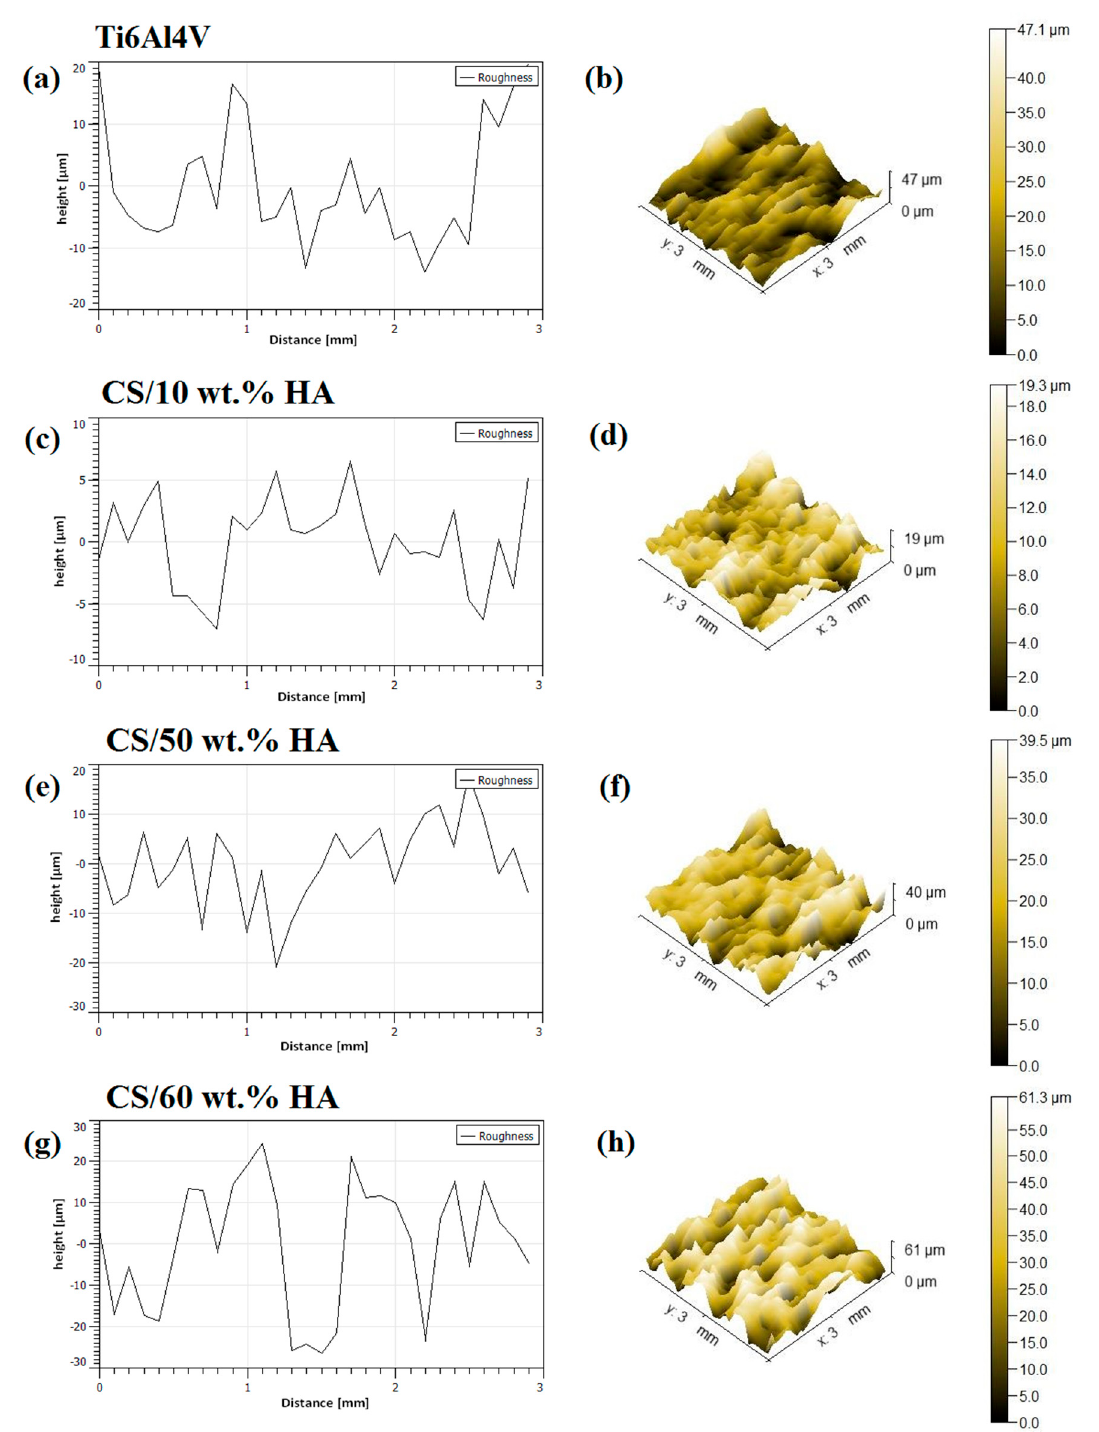
Figure 4. 2D and 3D optical interferometry images revealing micro-waviness ( a , c , e , g ) and macro- waviness ( b , d , f , h ) features of alkali-treated Ti6Al4V surface, CS / HA coating surfaces consisting of various amounts of HA